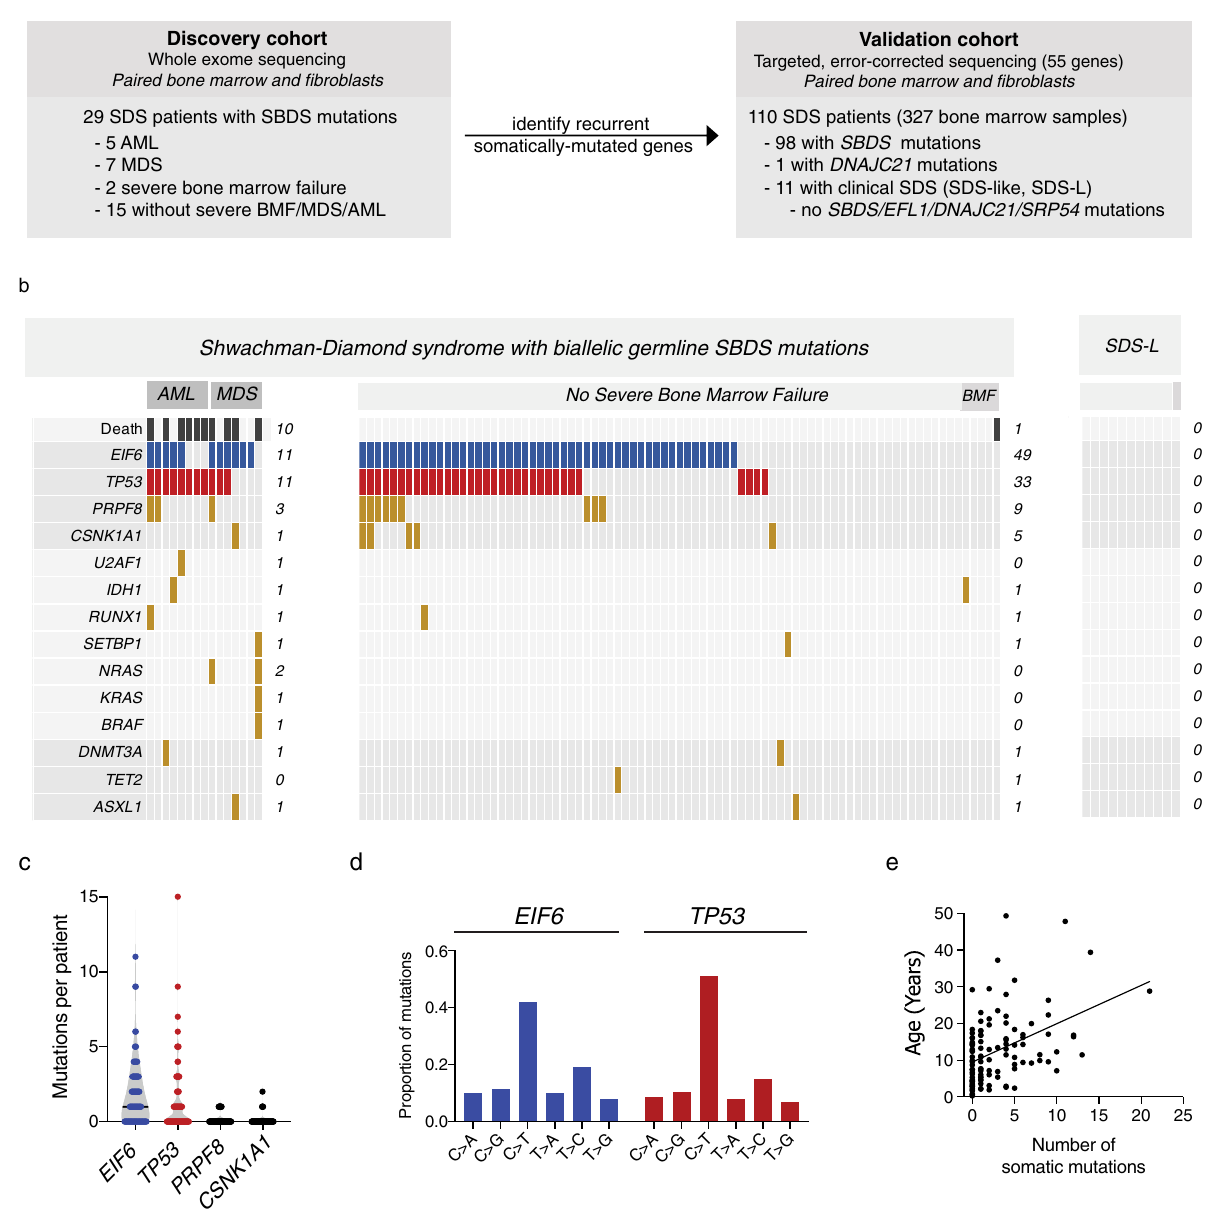
Fig. 1 Clinical factors associated with CH in SDS patients. a Schema of genomic analysis. b A co-mutation plot showing somatic mutations in individual genes as labeled on the left. Mutations are depicted by colored bars and each column represents an individual patient in the indicated study cohort. The sum total of each event or mutation are tabulated to the right of each plot. c Number of mutations per patient in each of the four most frequently mutated genes: TP53 , EIF6 , PRPF8 , and CSNK1A . d Base pair substitutions of somatic mutations in TP53 and EIF6 . e Total number of somatic mutations by age in patients with biallelic germline SBDS mutations, based on targeted deep